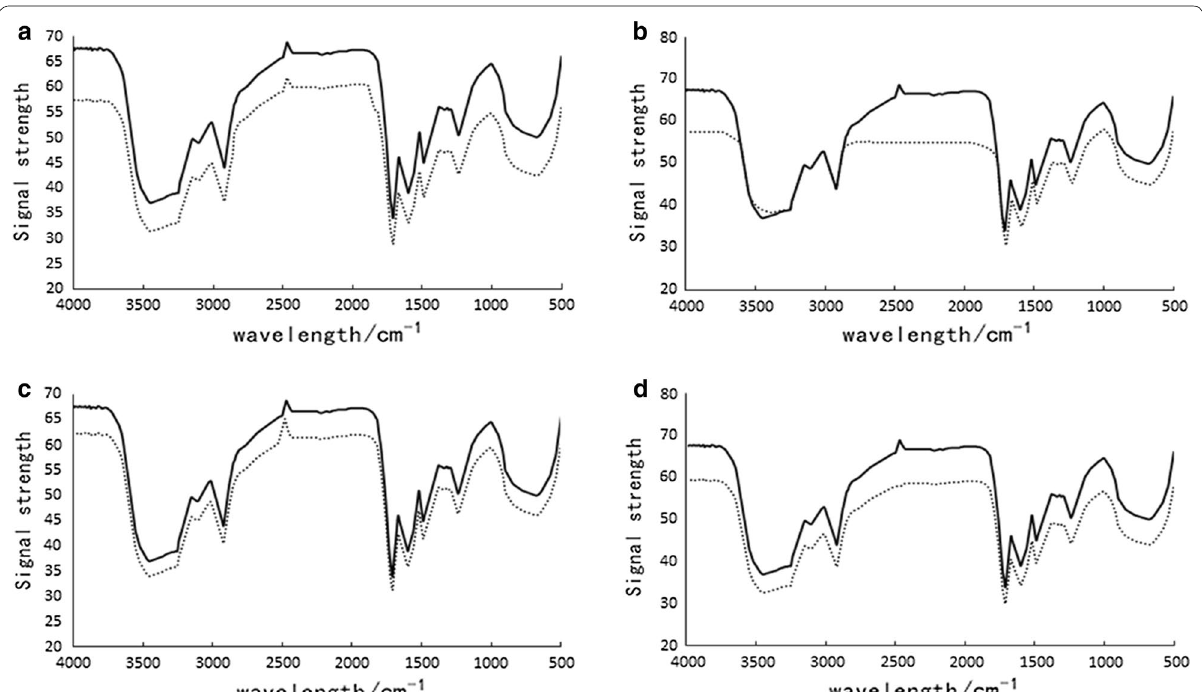
Fig. 4 FTIR spectra in the region 4000–400 cm − 1 for Cyanidin-3- O -arabinoside ( a ), Cyanidin-3- O -galactoside ( b ), Cyanidin-3- O -glucoside ( c ) and Cyanidin-3- O -Xyloside ( d ) and their polyphenol